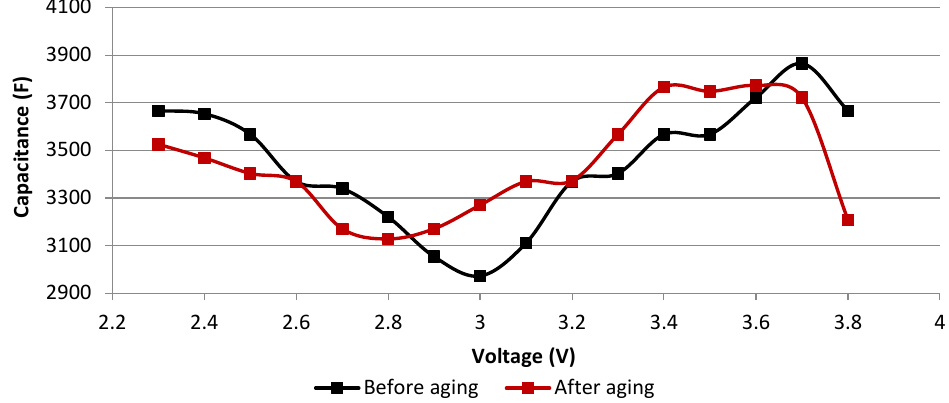
Figure 5. Effects of aging at 3.8 V and 60 °C for 109 days on the capacitance evolution with respect to the voltage, deduced from time domain measurements at 25 °C.